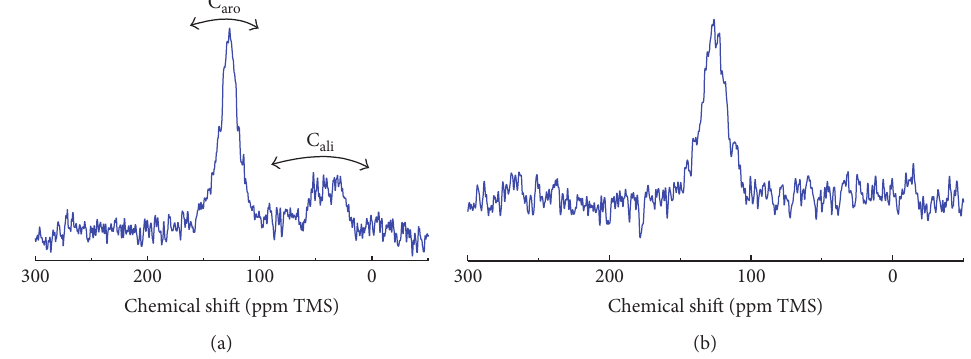
Figure 2: 13 C CP/MAS NMR spectra of plasma blacks produced by pyrolysis of natural gas in plasma reactors using (a) N 2 or (b) Ar.